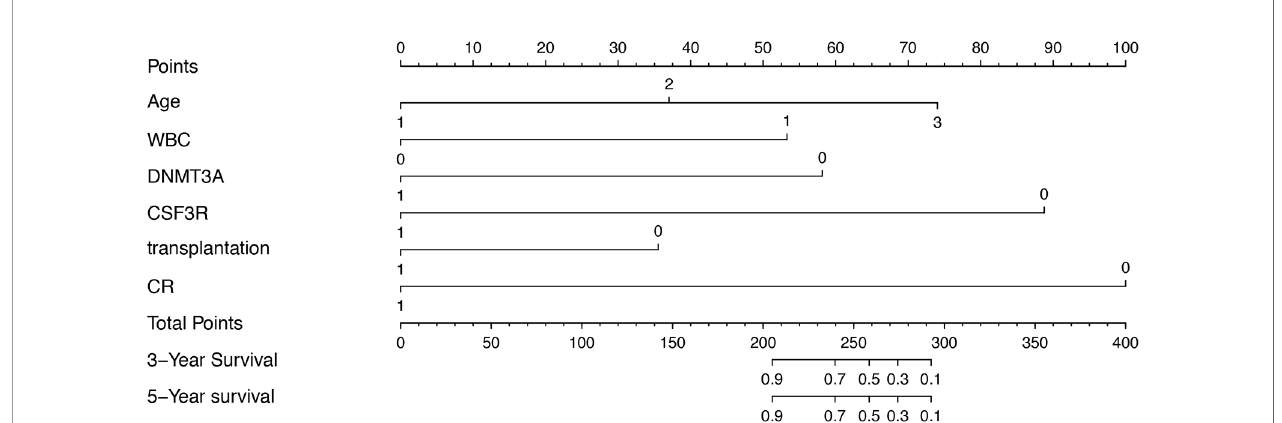
FIGURE 2 | Prognostic nomogram for AML patients with bi CEBPA mutations. Age: 1, age < 35 years; 2, age between 35-50 years; 3, age > 51 years. WBC: 1, WBC>25*10 9 /L; 0 WBC<25*10 9 /L. DNMT3A : 1, DNMT3A mutation positive; 0, DNMT3A mutation negative. CSF3R : 1, CSF3R mutation positive; 0, CSF3R mutation negative. Transplantation: 1, HSCT; 0, non-HSCT. CR: 1, complete remission after one course of induction therapy; 0, failure to achieve complete remission after one course of induction